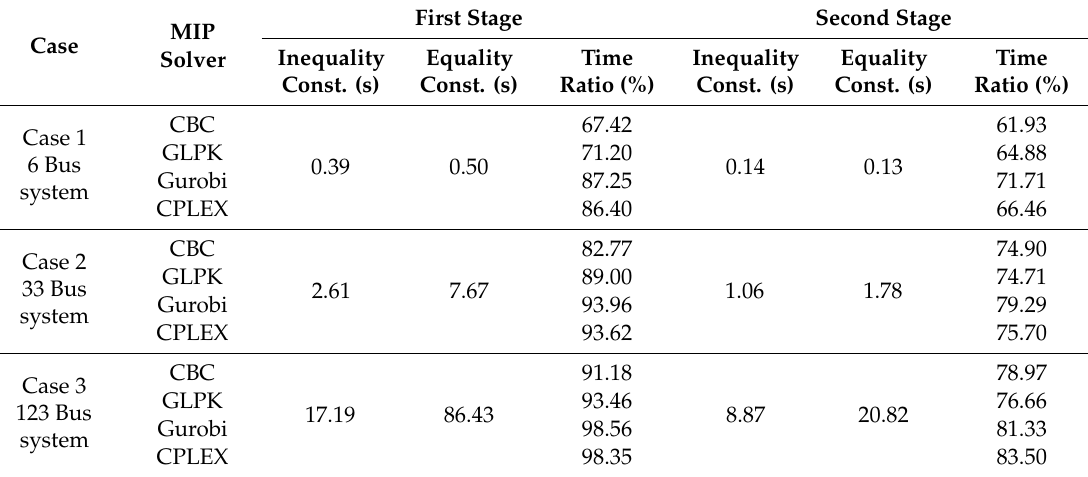
Table 7. Detailed computation time for the modeling package.